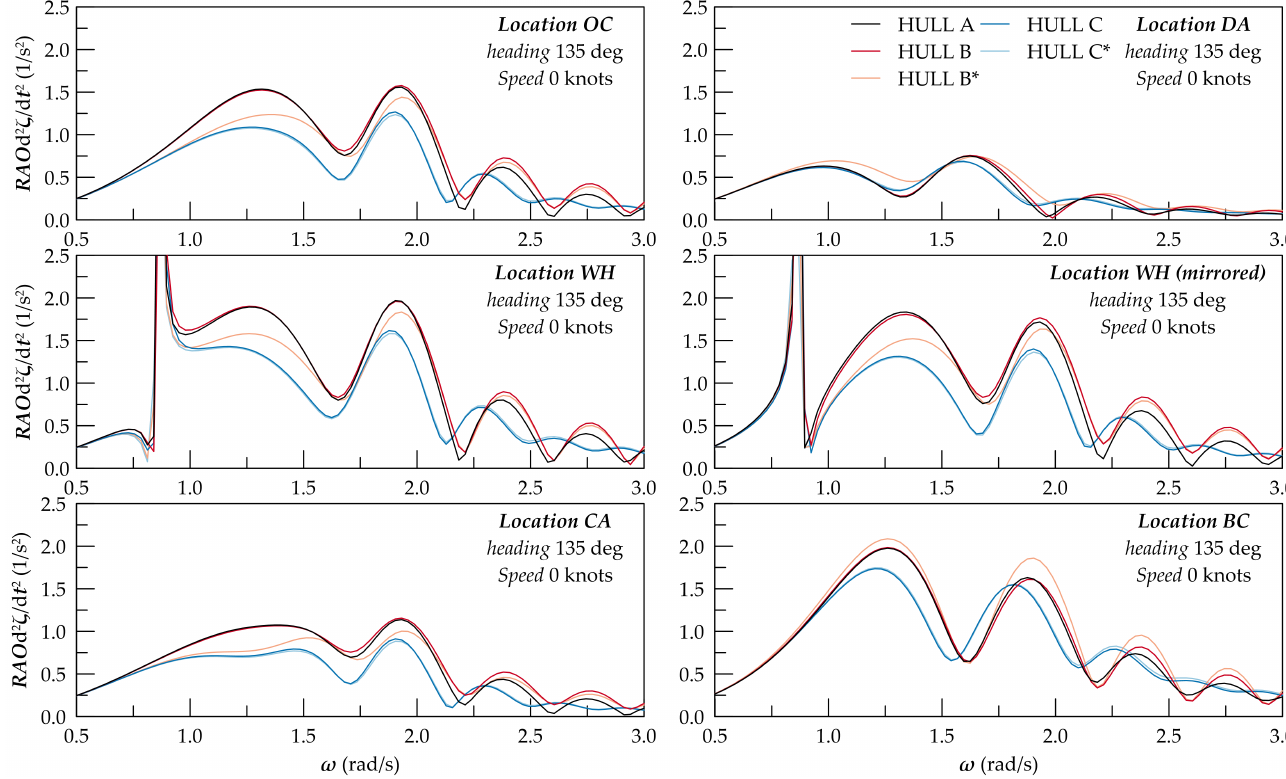
Figure 15. Absolute vertical acceleration RAO at 0 knots on the five reference hulls for the AWI